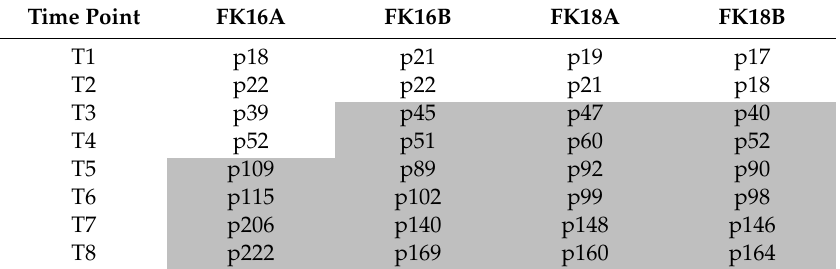
Table 1. Passage numbers included for all four HPV-transformed cell lines